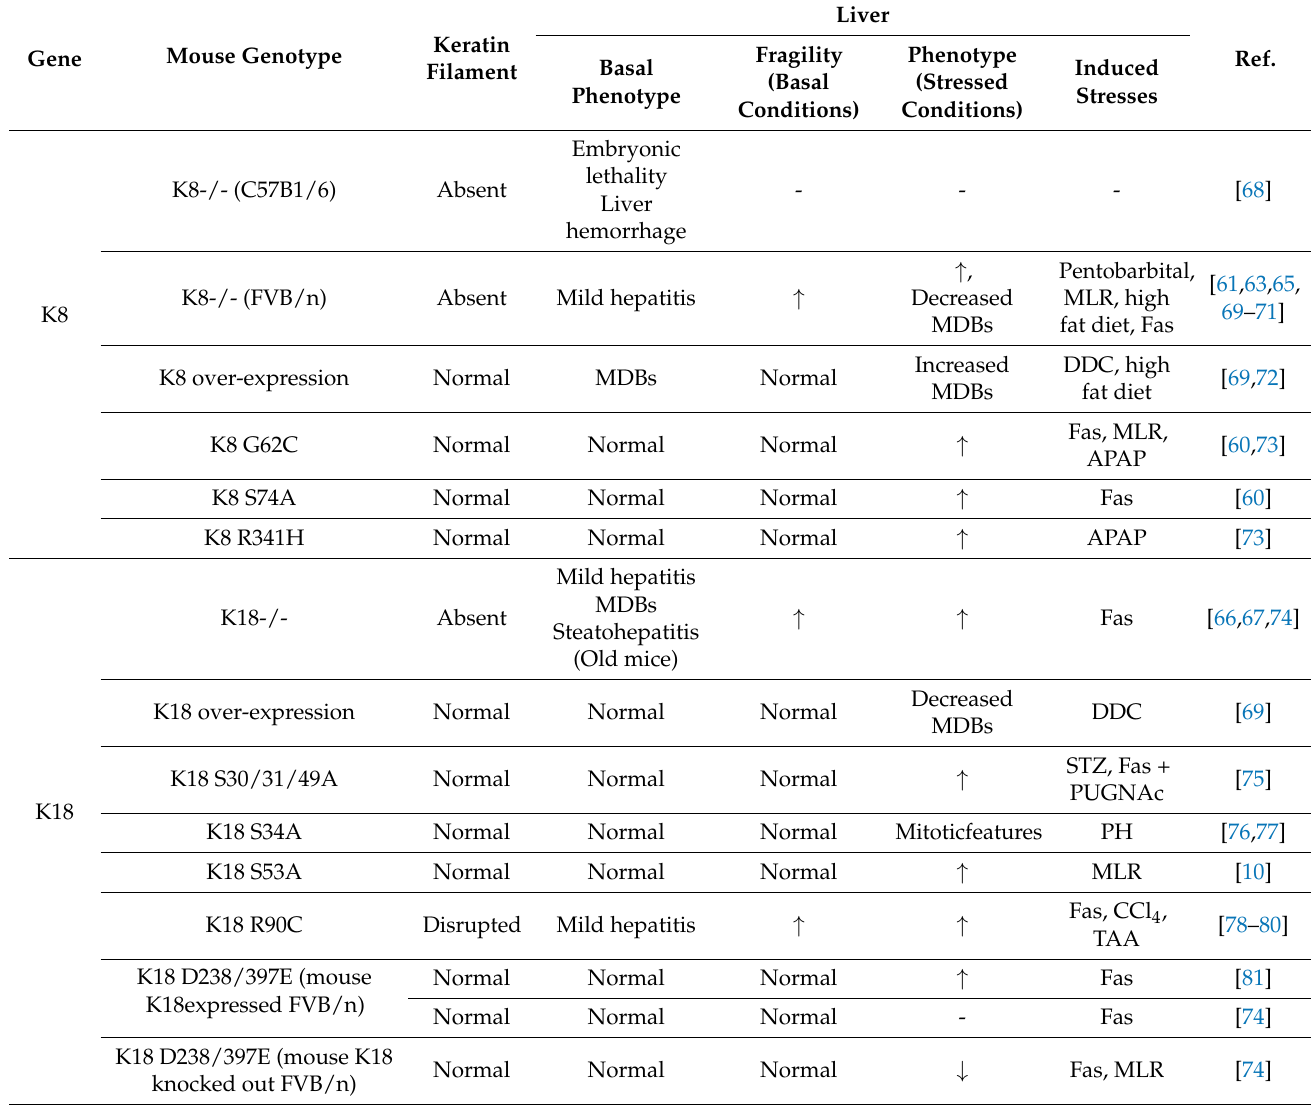
Table 3. Liver phenotypes of K8/K18-related mouse